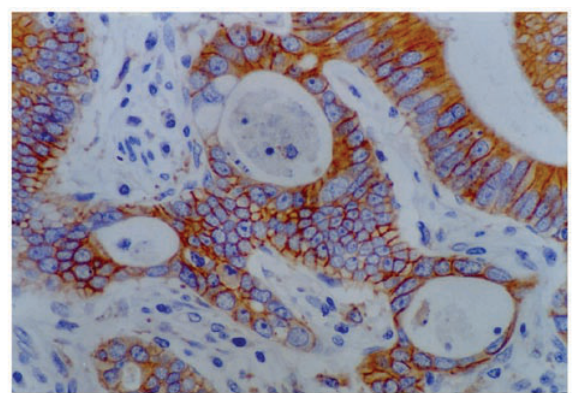
Figure 1. Immunohistochemical cytoplasmic expression of DCC protein in gastric adenocarcinoma (x